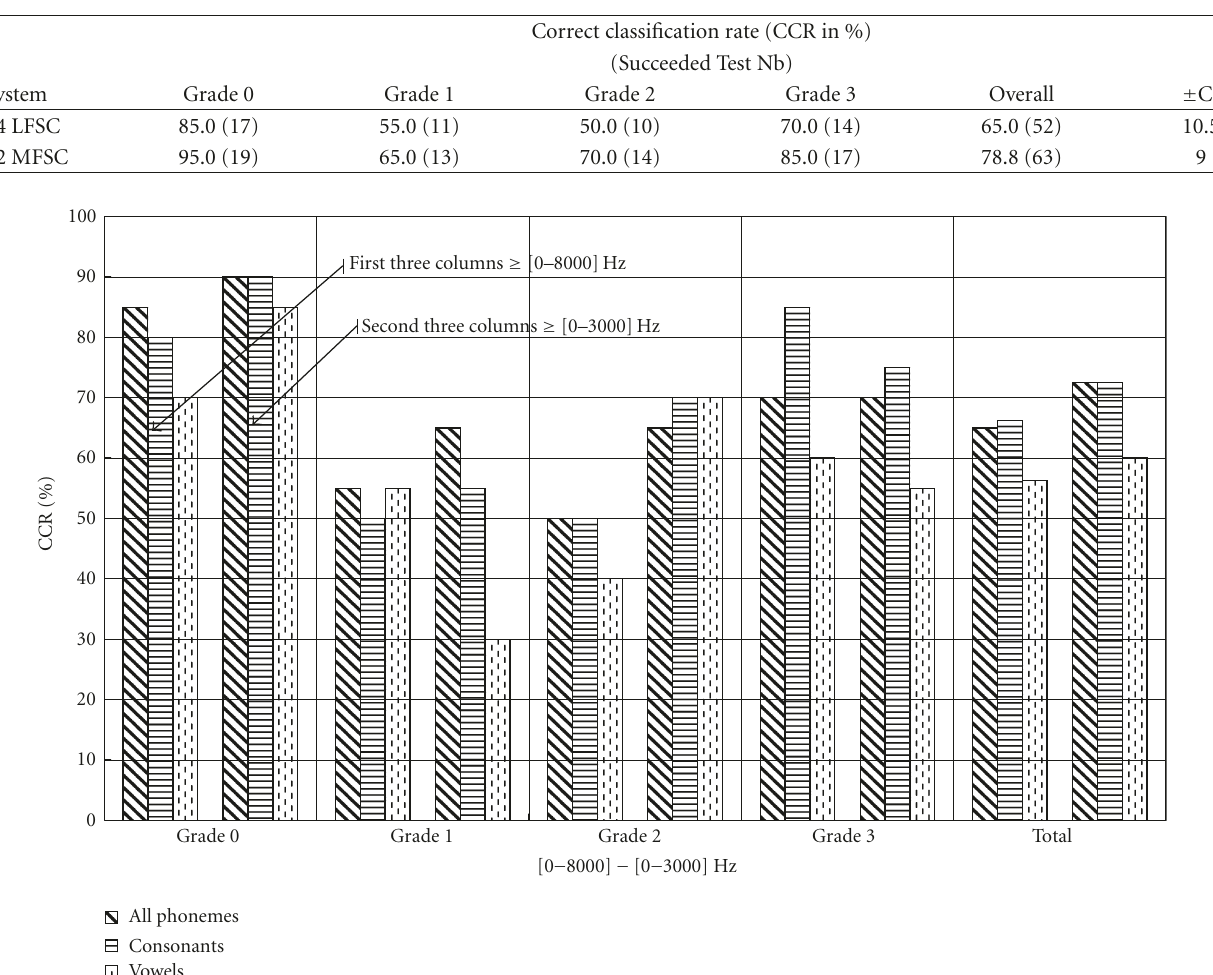
Table 2: Performance of the 4-G classification (Task2) expressed in terms of correct classification rates (CCR in %) as well as the number of succeeded tests (in parentheses) on the DV corpus according to two parameterization configurations (24 LFSC and 72 MFSC). Confidence intervals (CI) are provided for the overall scores.